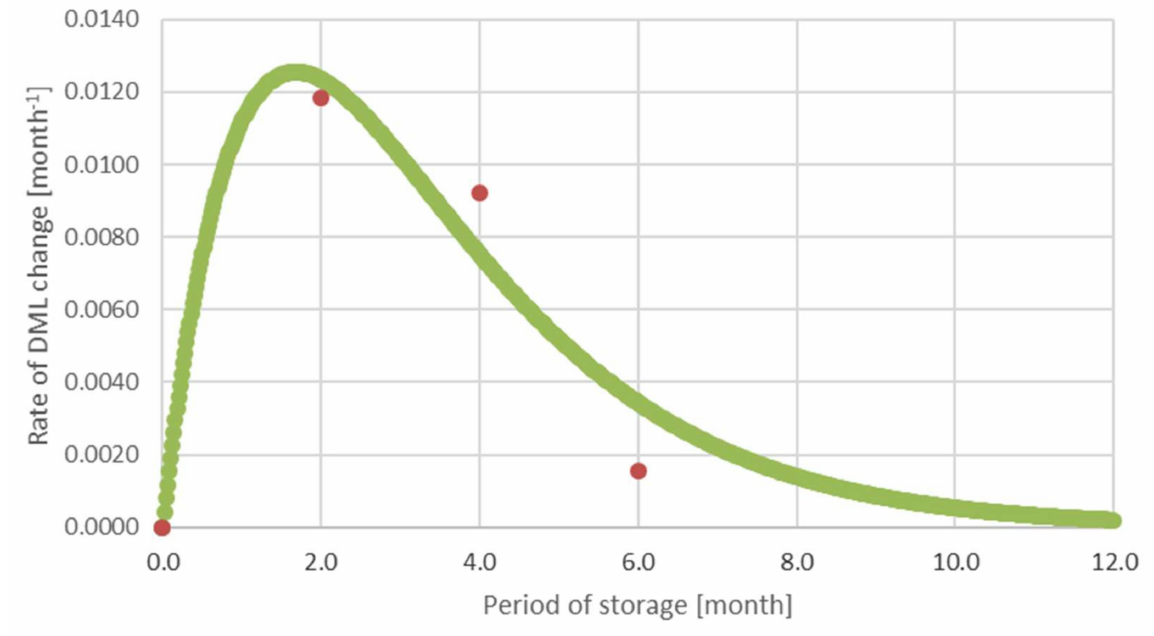
Figure 6. Estimation of the rate of DML change during the storage (red points denote the measured values, green line shows the graph of the Equation